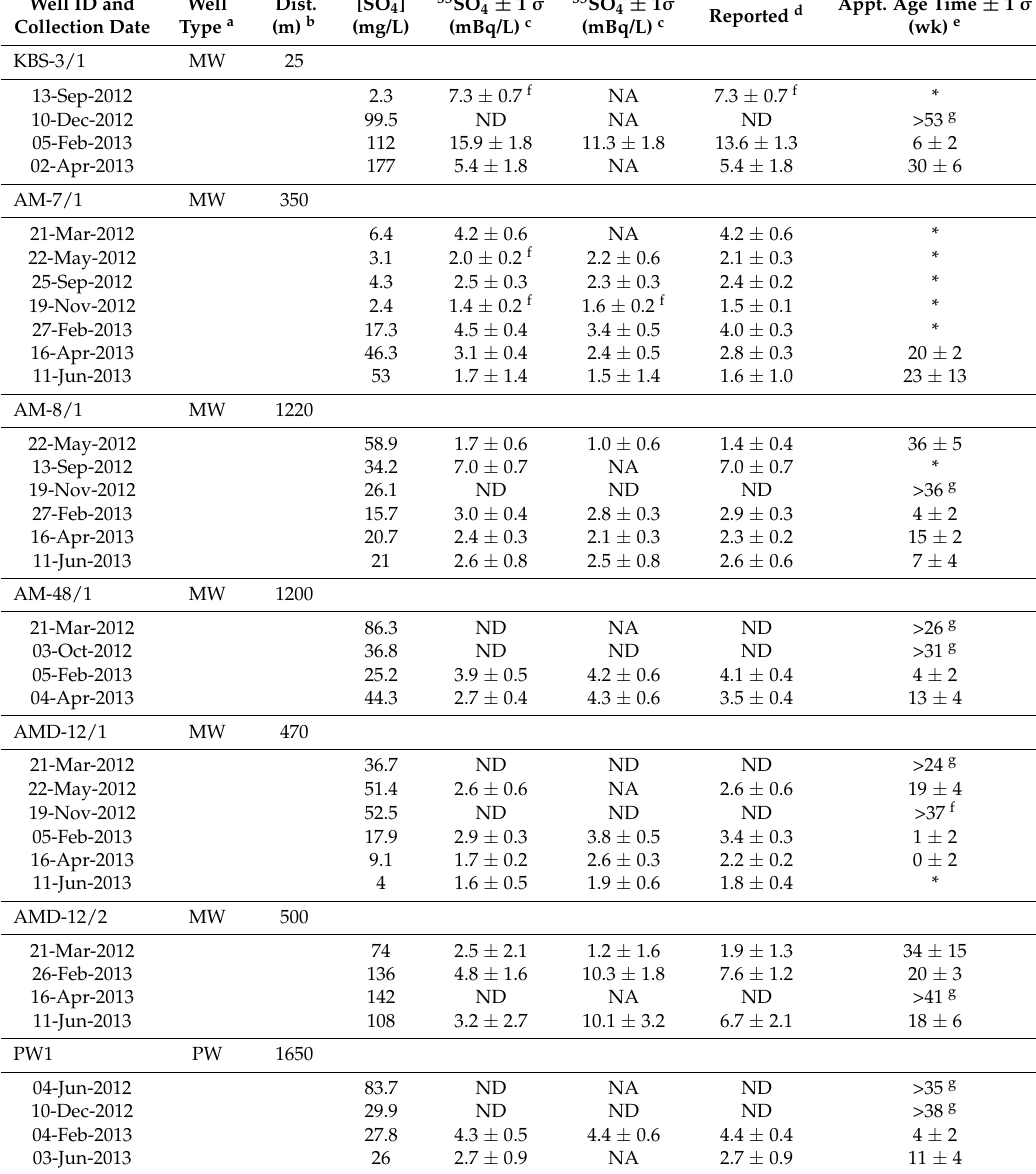
Table 3. Well type, downgradient distance, [SO 4 ], 35 SO 4 activity, and 35 S apparent age for groundwater at OCWD MAR sites. The apparent ages were calculated assuming the A 0 of the source water using Equation (2) and the error is the 1 σ propagated counting error. Data from